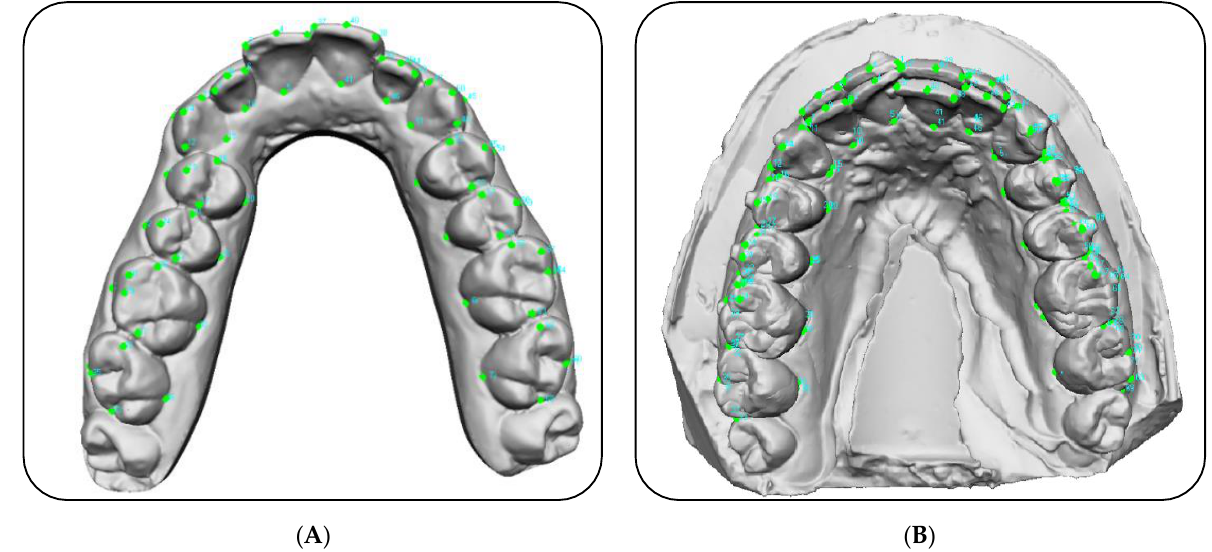
Figure 1. ( A ) Position of the 72 reference points. ( B ) Superimposition with the 72 reference points between T0 and T1 maxillary arch.